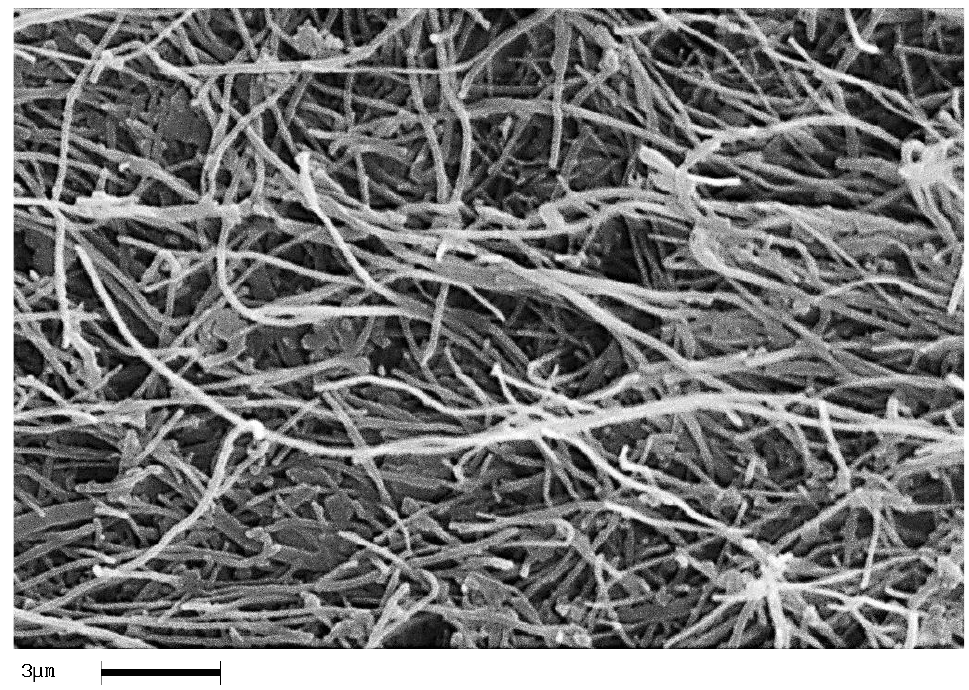
Figure 19. Fracture surface SEM image of the TBD + 0.64%MWCNTs sample.